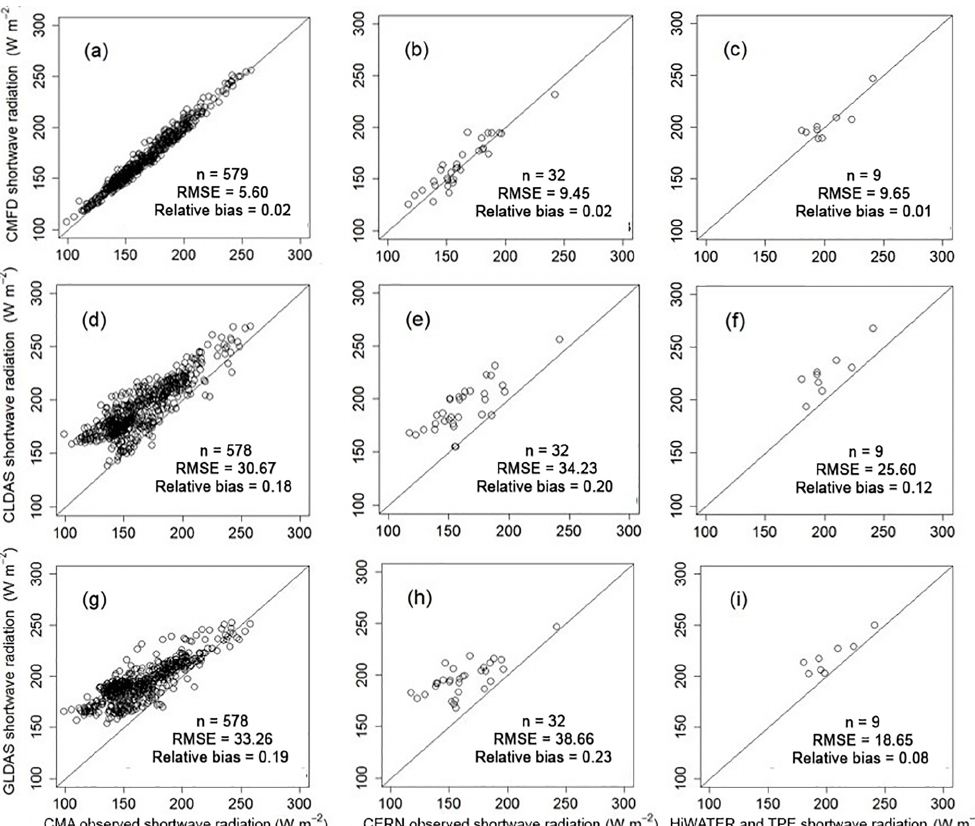
Figure 8. Relationships between shortwave radiation from forcing data and shortwave radiation based on station observations.